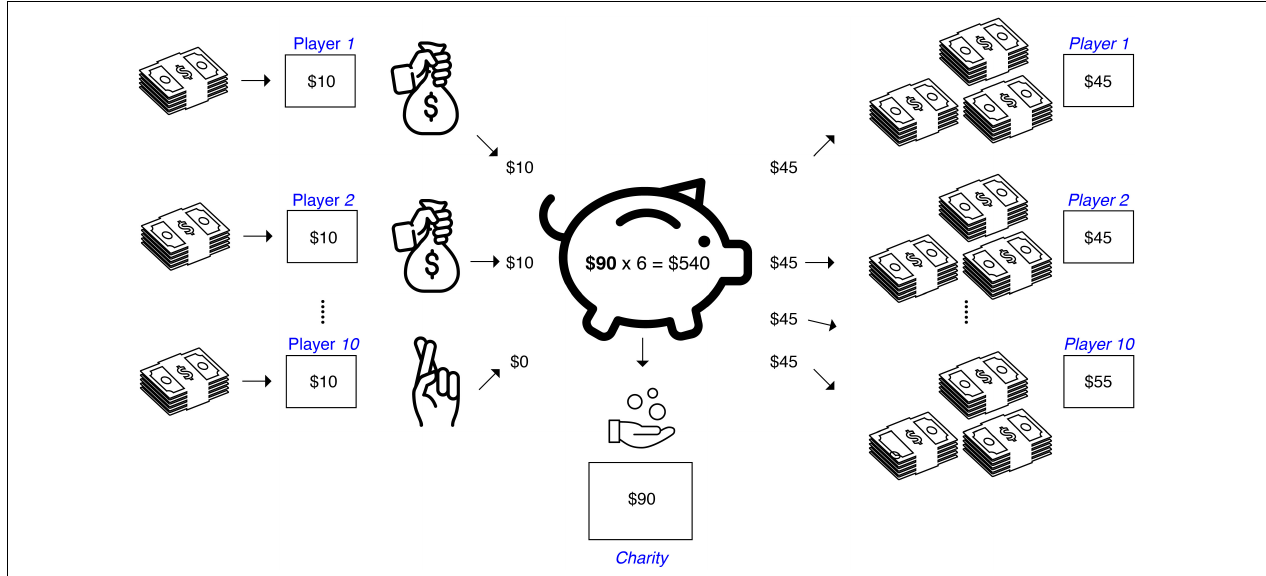
FIGURE 1 | Illustration of the Iterative Public Goods Game with a Charity/3rd-Party Organization. Left: agents either contribute their wages into the shared account, or anonymously defect. The amount in the shared account is multiplied during the day. Center: A cut of the total yield is donated to Charity (/3rd-Party), and the rest (right) is divided equally among all players (including the defecting